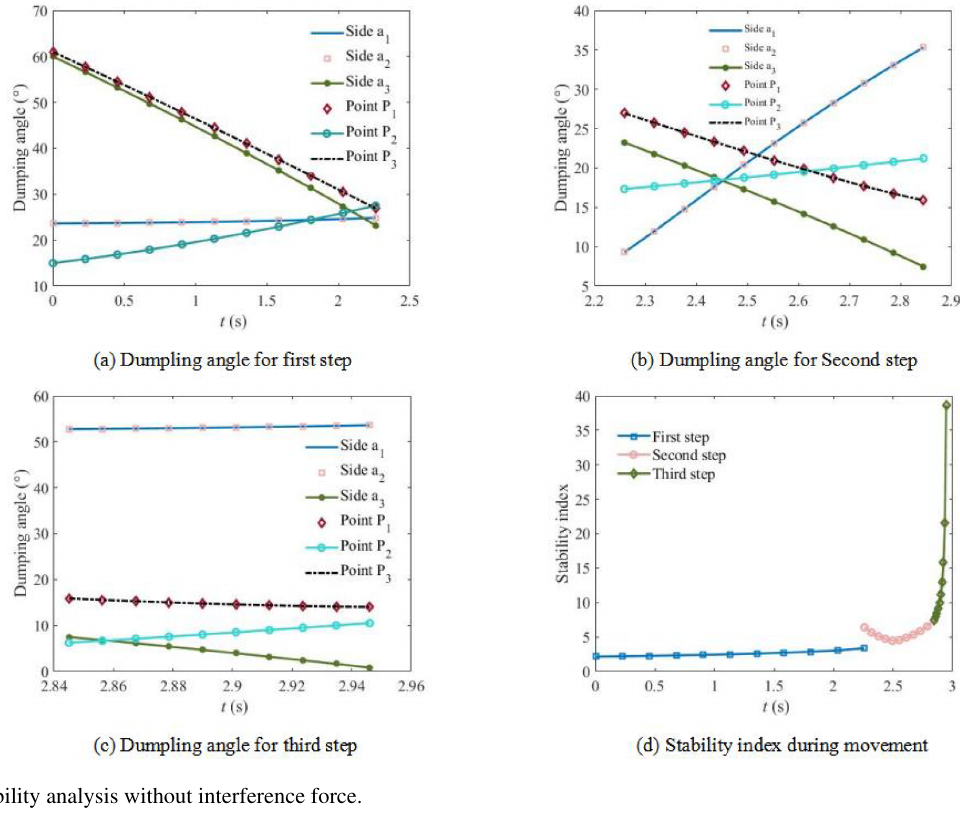
Figure 16. Stability analysis without interference force.